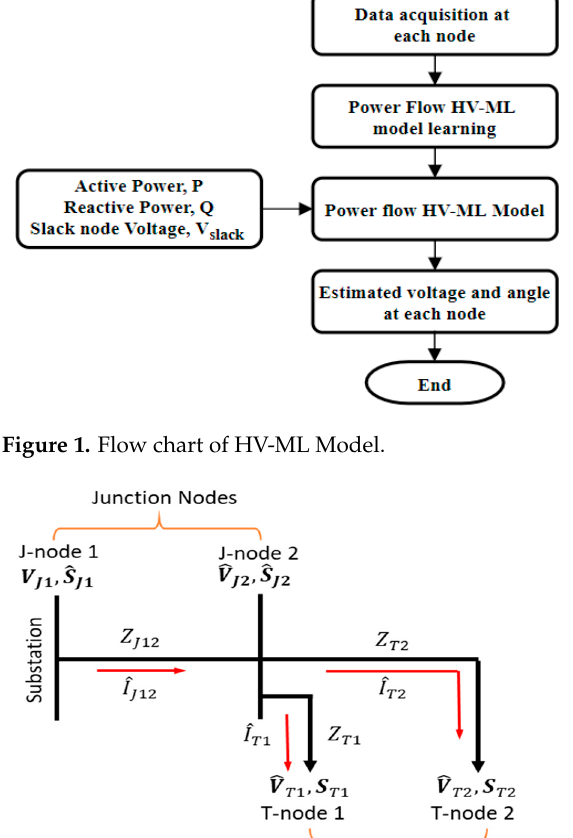
Figure 2. Simplified Linear High-Voltage Distribution network topology .